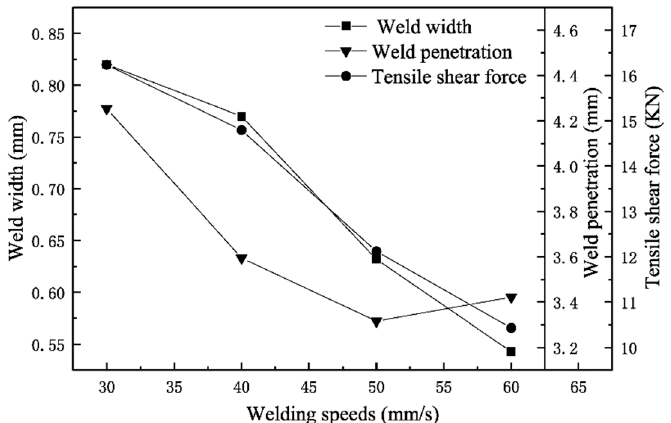
Figure 11. The schematic diagram of weld penetration, weld width and tensile-shear force changes at different welding speeds.